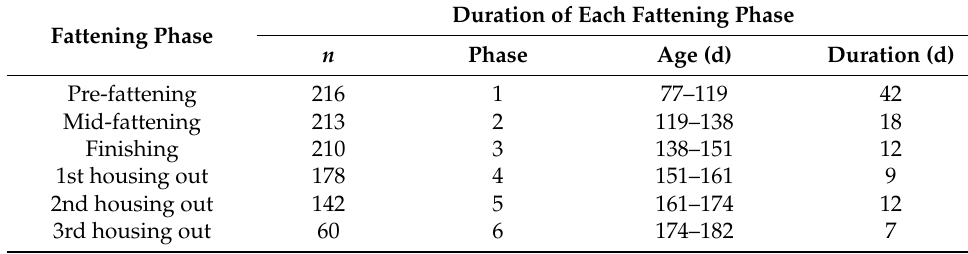
Table 2. Chronology of the fattening